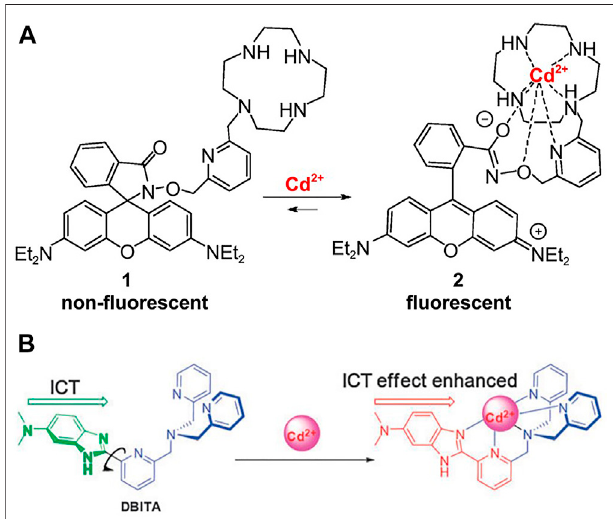
FIGURE 9 | (A) Binding of Rhodamine-Cyclen Probe 1 with Cd 2+ (Shim and Tae, 2011); (B) Proposed Cd 2+ binding mode of DBITA (Liu et al., 2010).